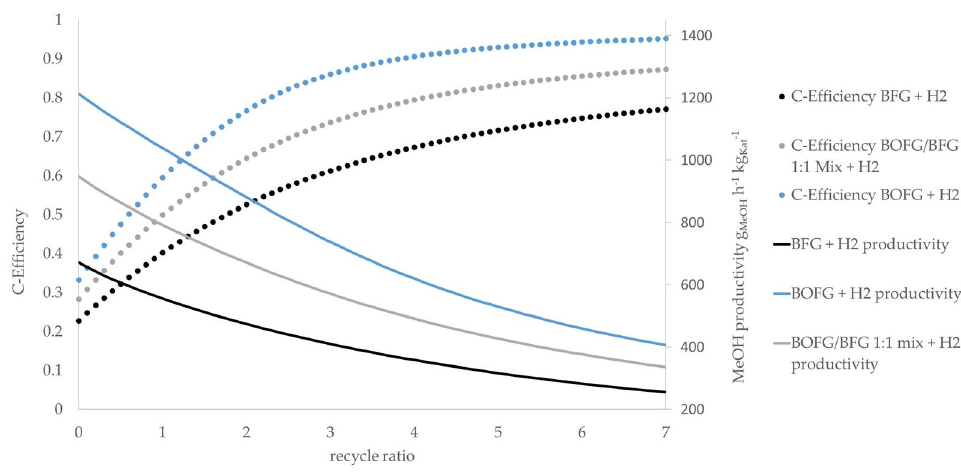
Figure 7. Simulation results of four gas-utilization scenarios.